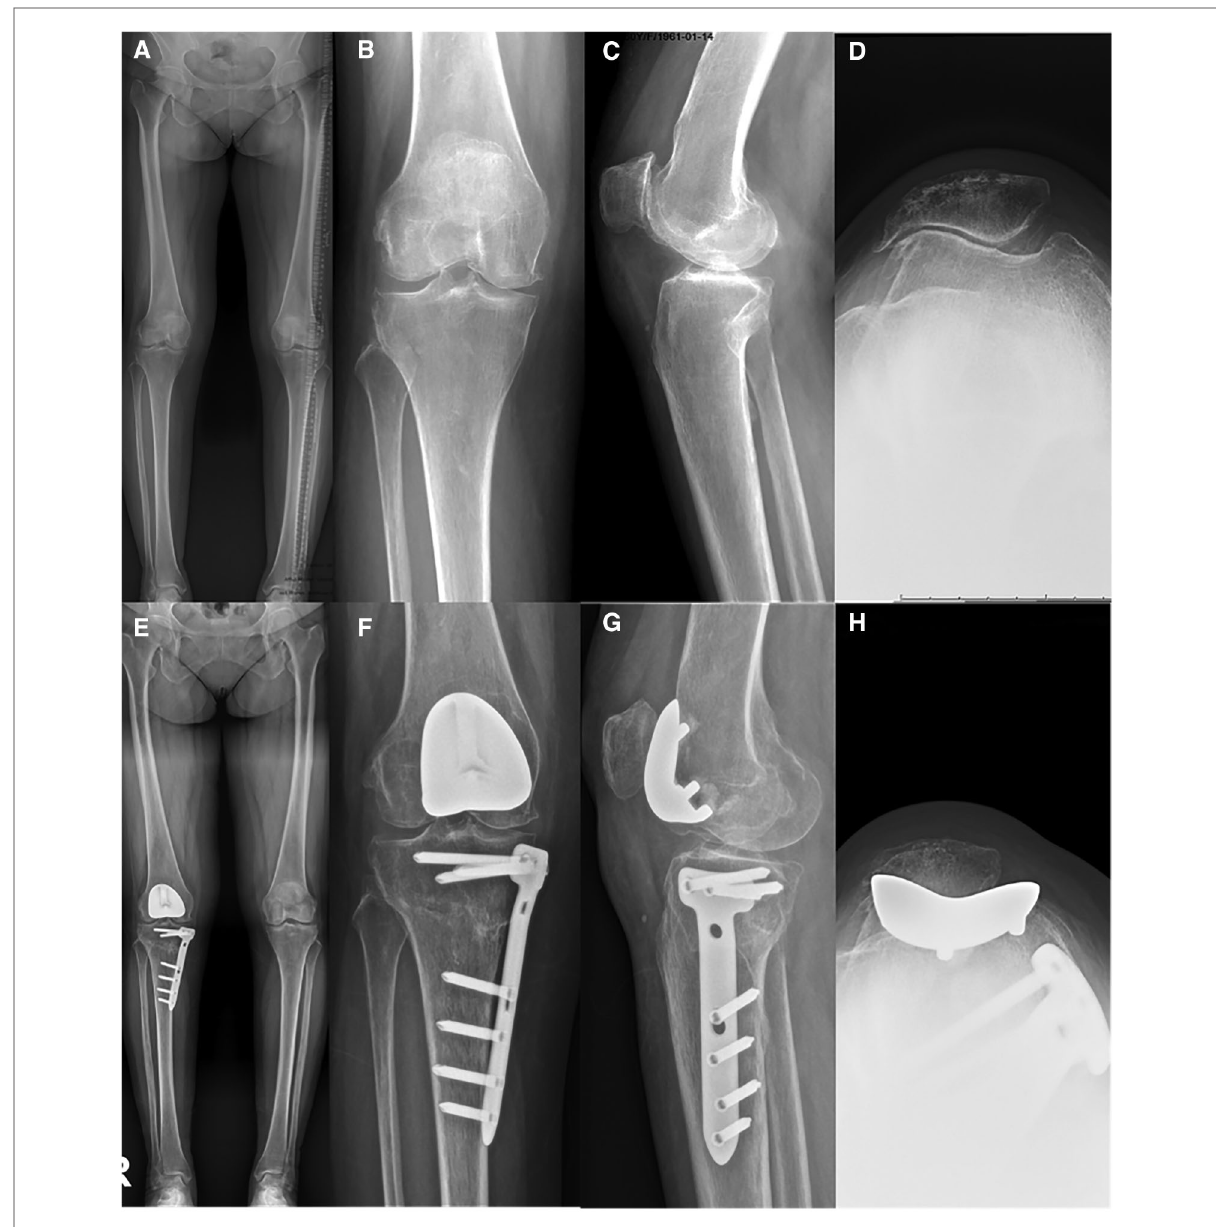
FIGURE 1 X-rays of a patient with the patellofemoral arthroplasty in combination with high tibial osteotomy preoperative ( A – D ) and postoperative at six months ( E – H